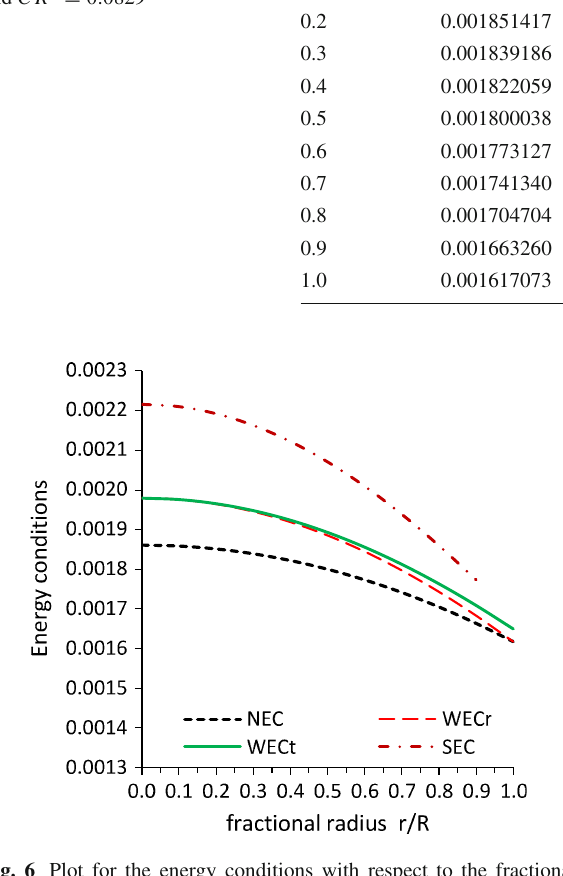
Table 2 Values of the energy conditions for the constants n = 1, m = 5, N = 11, a = 1, b = 0 . 25, K = 0 . 11, β = 4 . 2395